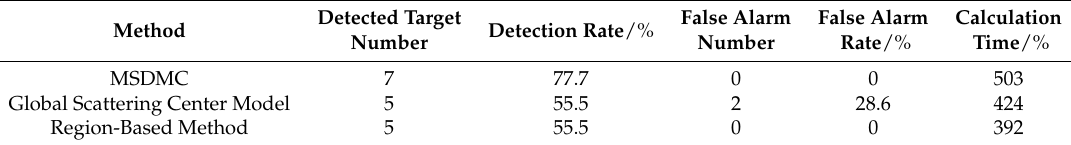
Table 5. Target-detection results on the Wuhan data set using different